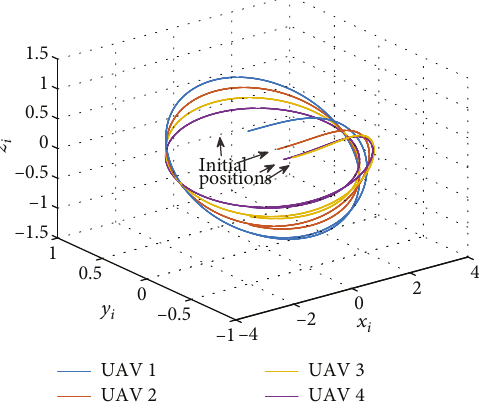
Figure 4: State trajectories of the closed-loop FTBF trajectory.